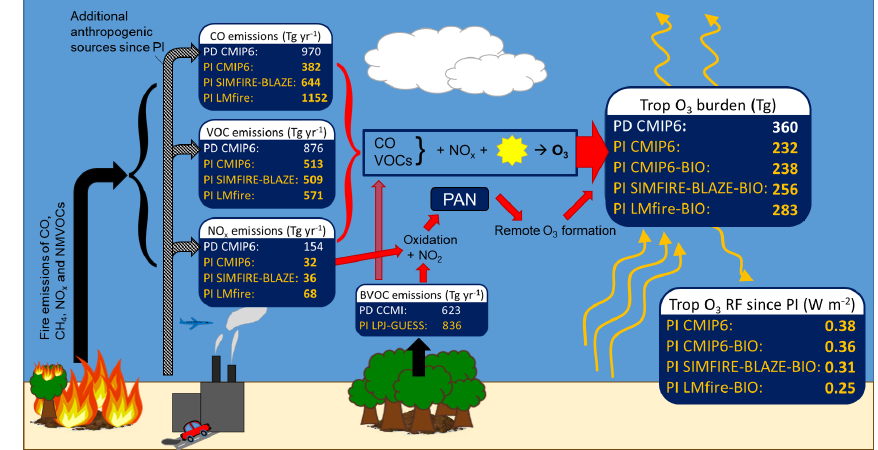
Figure 4. Summary schematic showing tropospheric O 3 precursor emissions from fire, biogenic and anthropogenic sources, the processes of photochemical O 3 formation, the tropospheric O 3 burden, and the PI-to-PD RF. The magnitude of CO, NO x , VOC and BVOC precursor emissions used in this study is shown for the PD (white text) and each PI inventory (yellow text). The resulting calculated tropospheric O 3 burden and RF when using each emission inventory are also